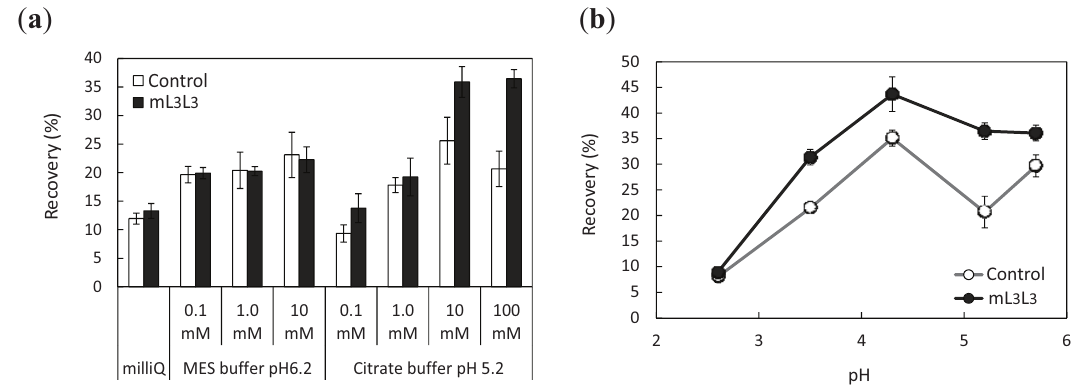
Figure 5. Recovery efficiencies of uranyl ions adsorbed on control and mL 3 L 3 yeast strains. ( a ) Recovery of the adsorbed uranyl ions by ultrapure water (milliQ), MES buffer (pH 6.2), and citrate buffer (pH 5.2) at various concentrations (0.1–100 mM); ( b ) pH-dependence of recovery efficiencies using 100 mM citrate buffer (indicated pHs). Data represent the means ± S.E.M. of three independent